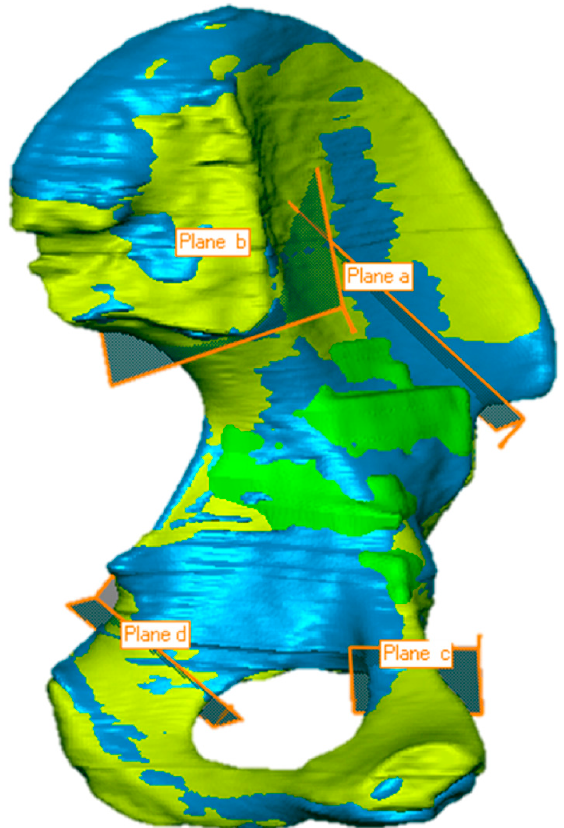
Figure 5. The four cutting planes (a-b-c-d) defined for the four osteotomies necessary to remove the bone stock with the tumor (in green). These virtual osteotomies are performed on both the affected (in yellow) and unaffected (in blue) hemipelvis, after registration as in Figure 4B.